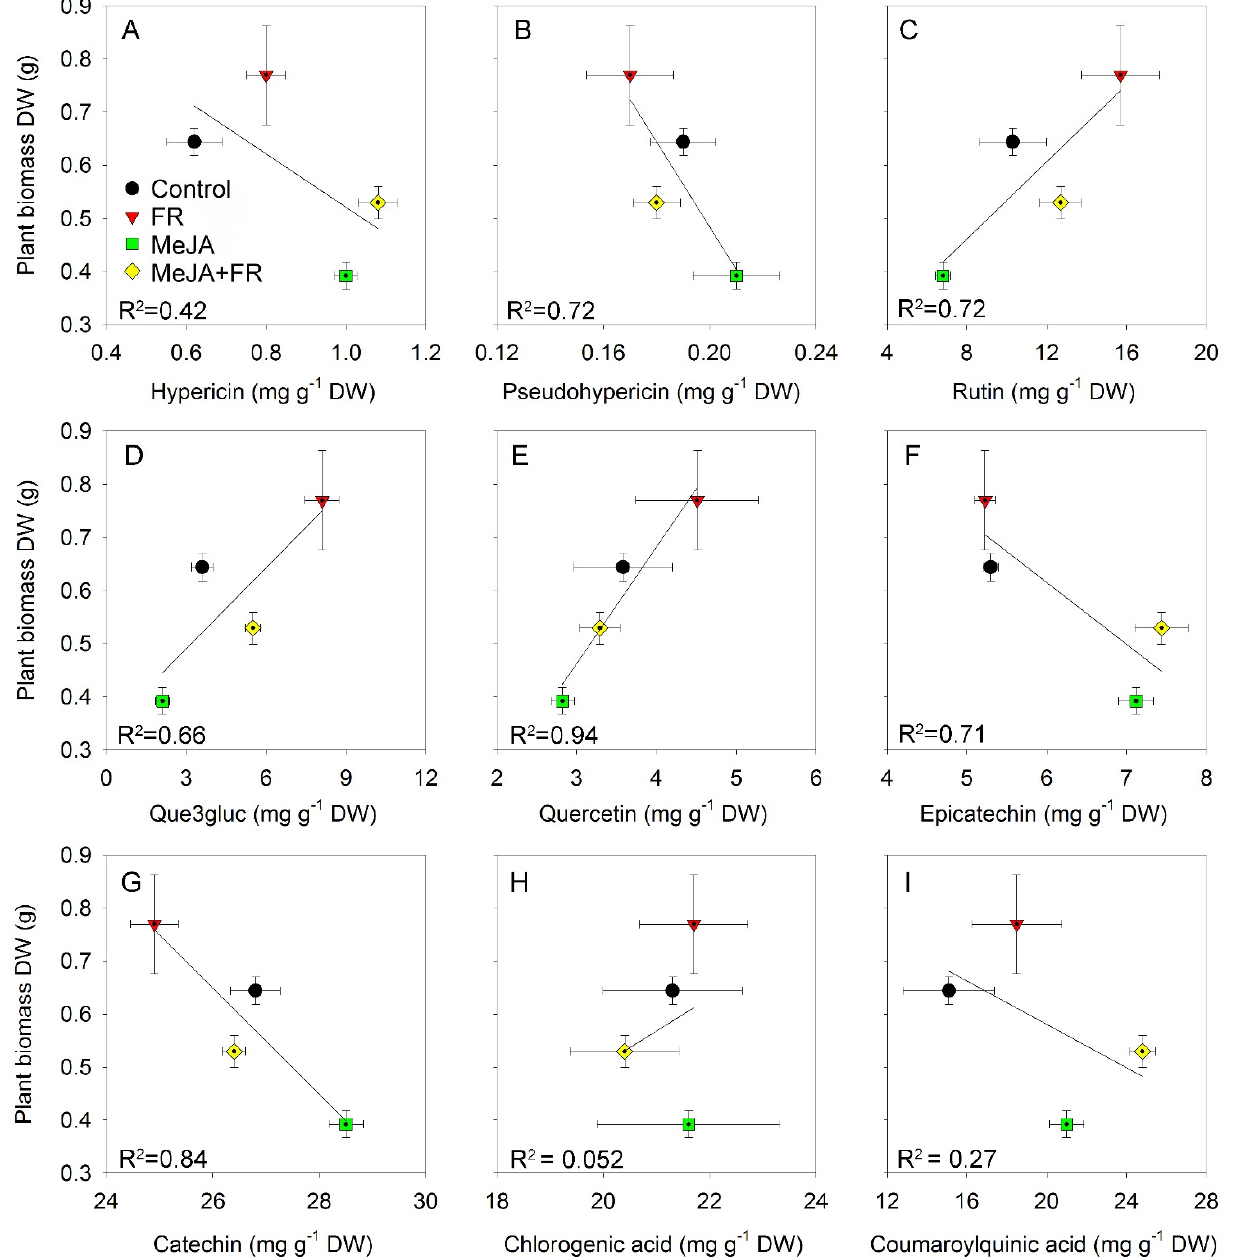
Figure 7. The relationship between plant biomass of Hypericum perforatum and hypericin ( A ), pseudo-hypericin ( B ), rutin ( C ), que3gluc ( D ), quercetin ( E ), epicatechin ( F ), catechin ( G ), chlorogenic acid ( H ), and coumaroylquinic acid ( I ) concentrations in leaves.